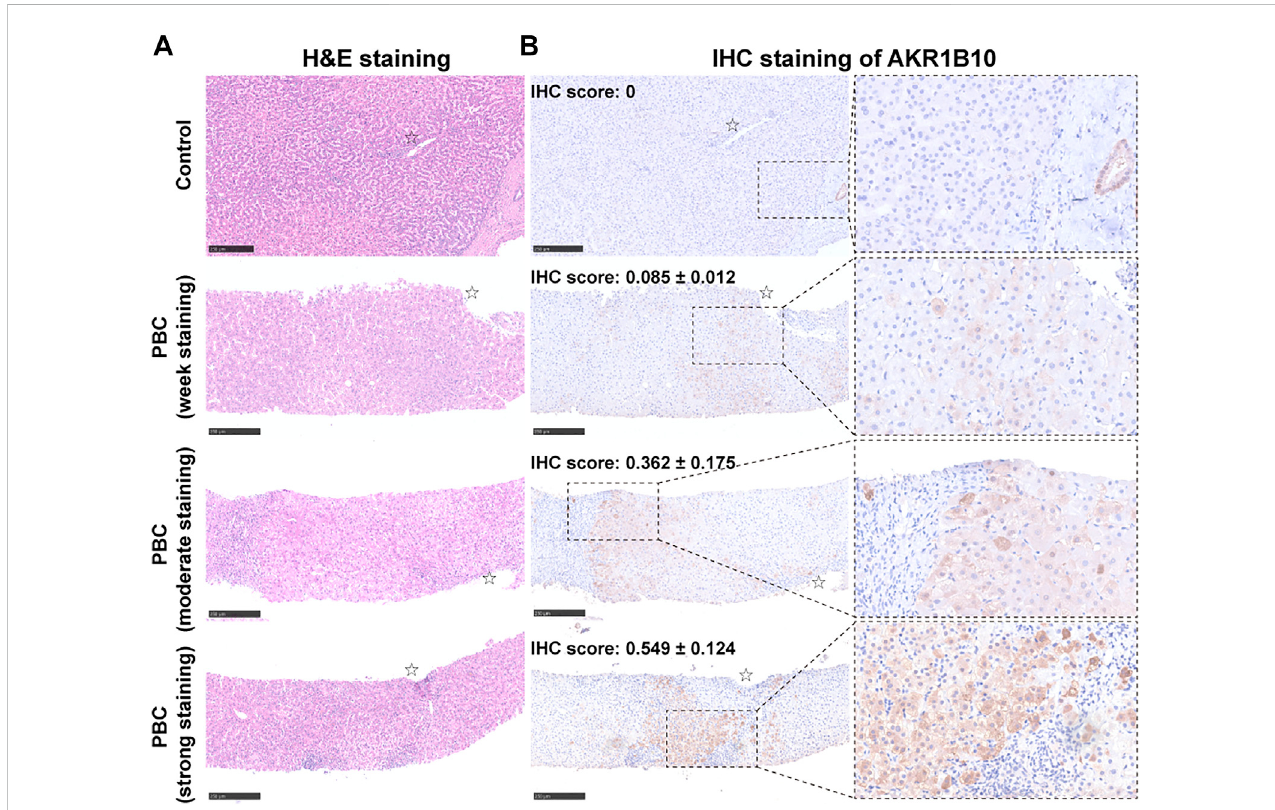
FIGURE 7 Histological and immunohistochemistry analyses of serial liver sections from patients with PBC and control patients. Representative images of hematoxylin and eosin (H&E) staining (A) and immunohistochemical staining of AKR1B10 with different staining intensities (B) in serial liver sections from healthy controls and patients with PBC. Scale bars: 250 μ m. AKR1B10, aldo-keto reductase family 1 member B10; PBC, Primary biliary